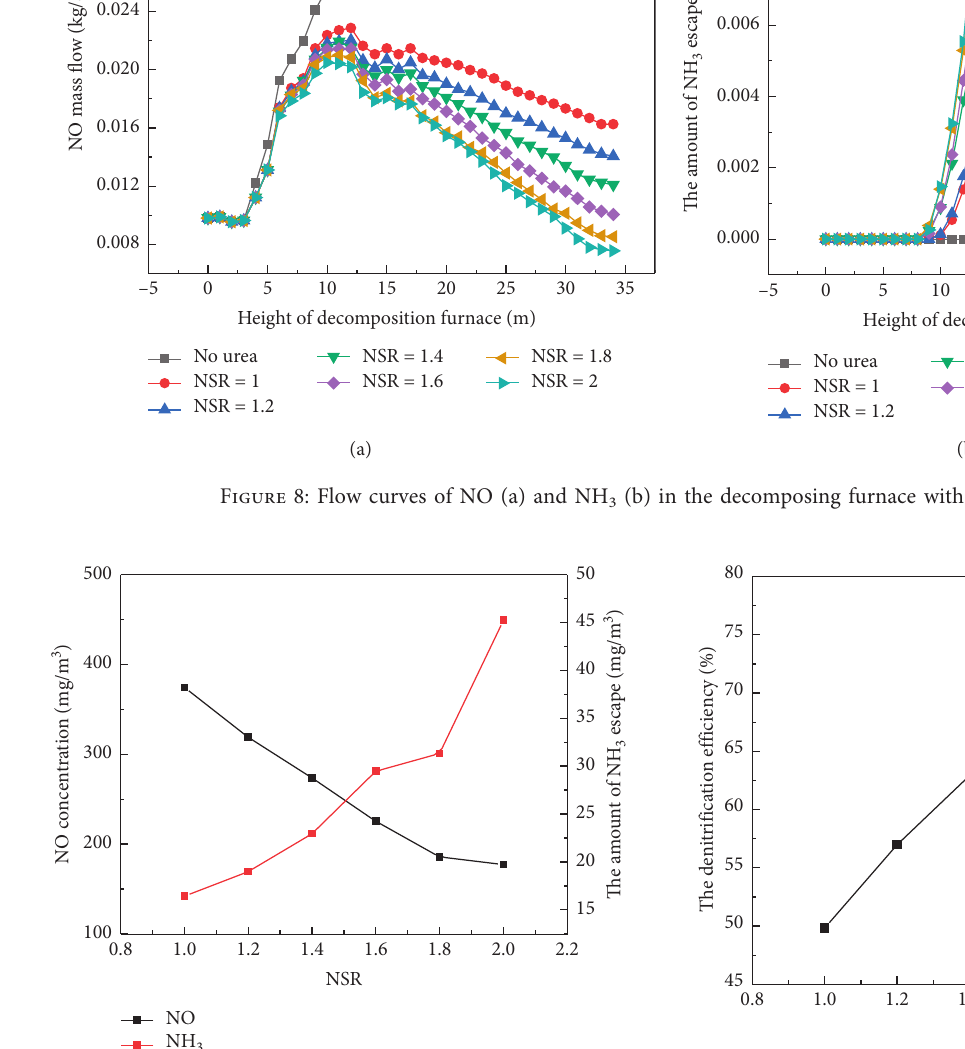
Figure 10: Variation of denitrification efficiency with 3 escape con-